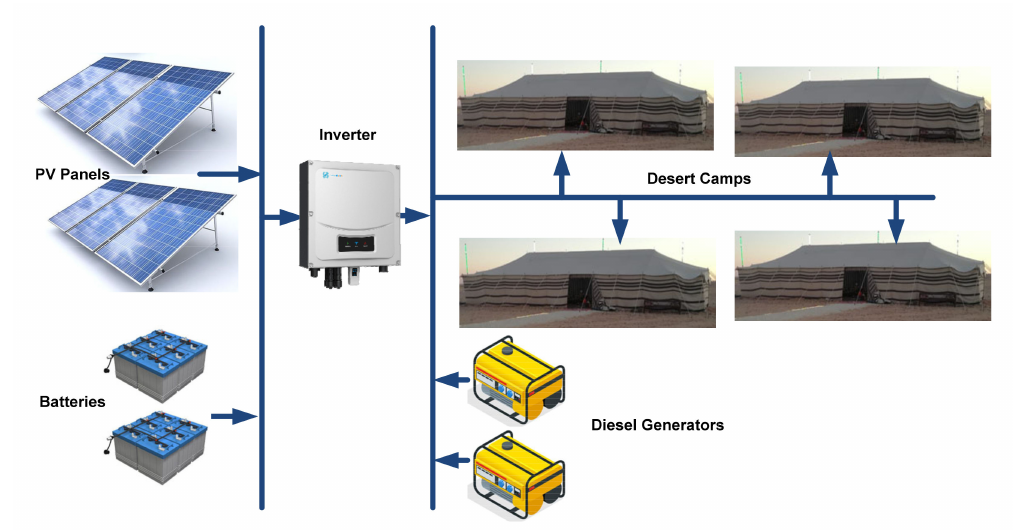
Figure 2. Standalone hybrid microgrid made up of multiple nanogrid for a desert